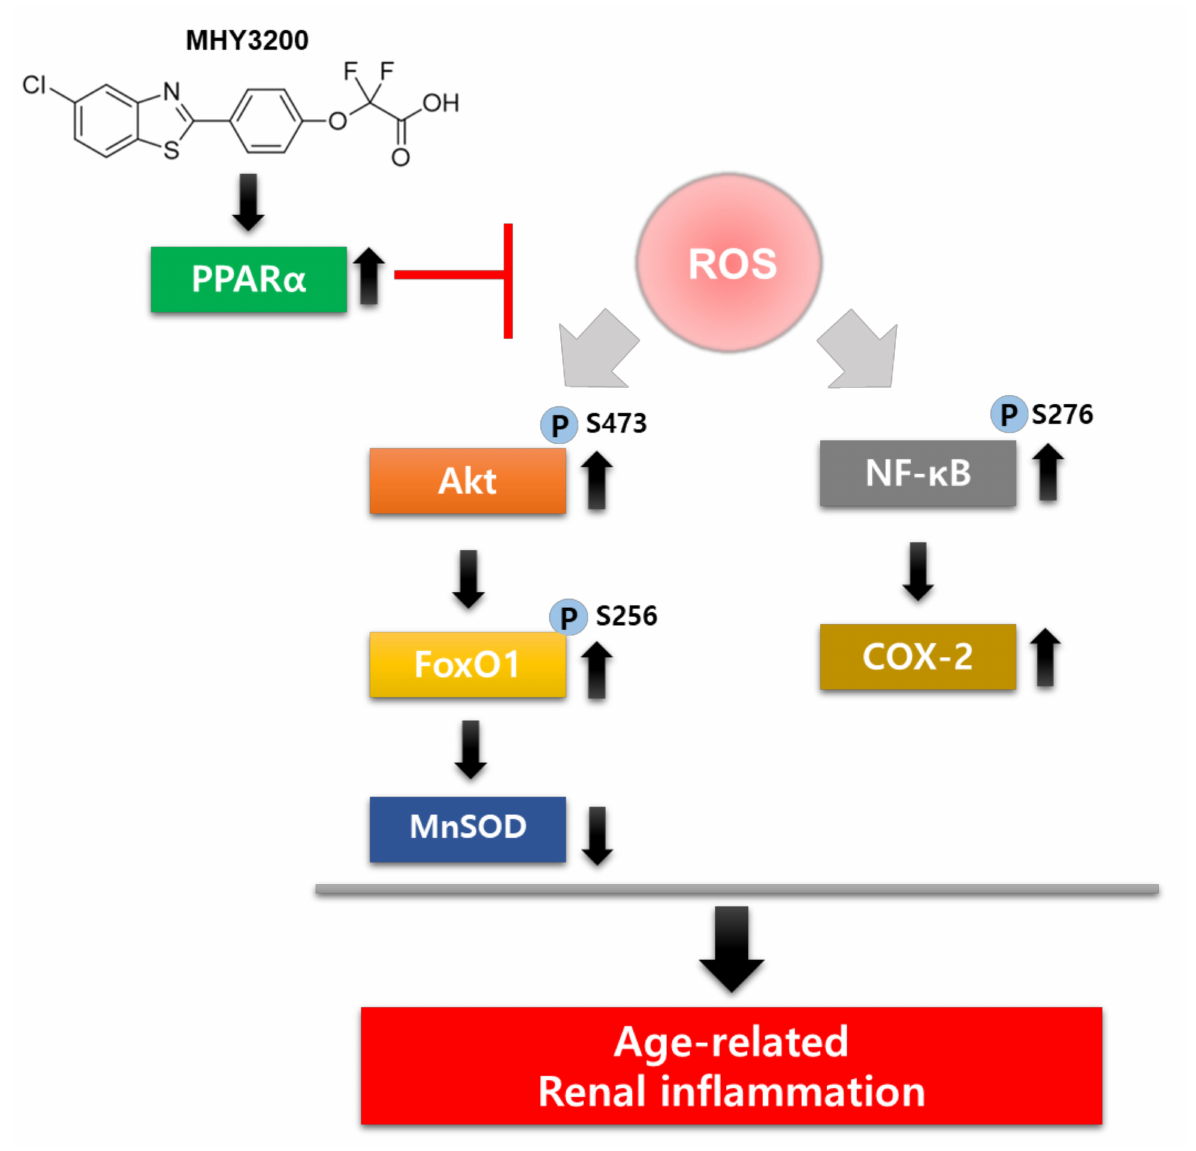
Figure 5. Possible role of MHY3200 in modulating ROS/Akt/FoxO1 signaling in kidney tissues of aged rats. MHY3200 ameliorated age-related inflammatory response by inhibiting the proinflammatory NF- κ B activity regulated by ROS/Akt/FoxO1